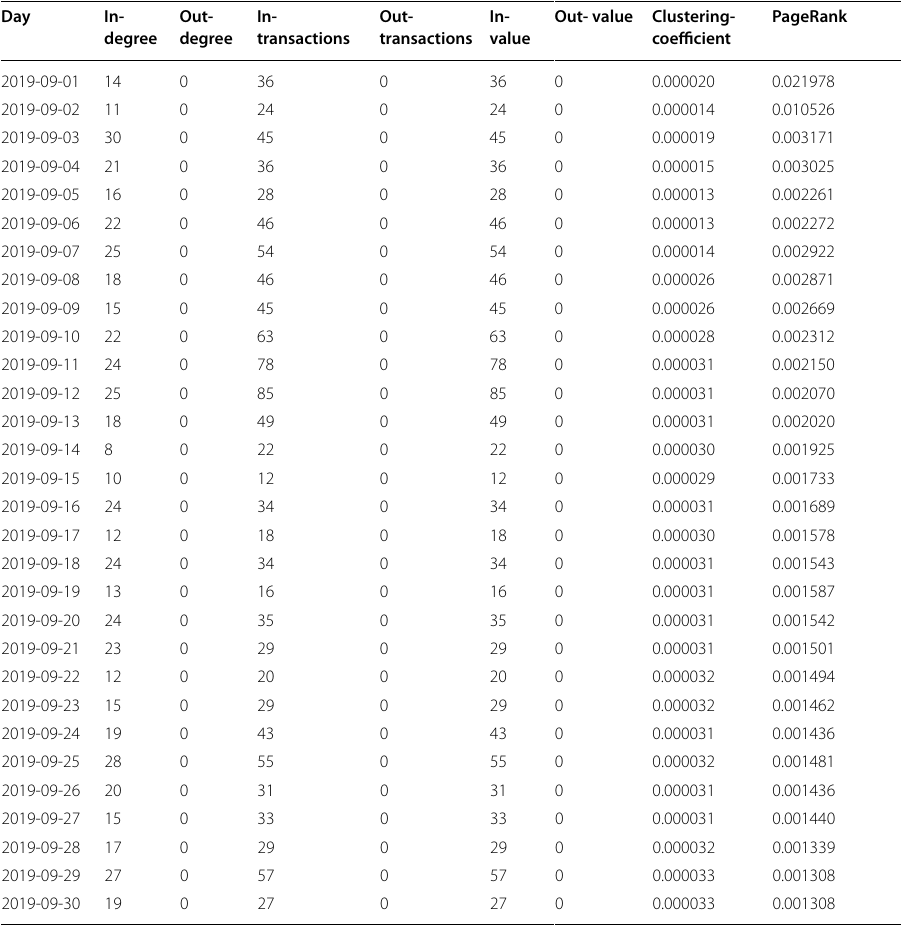
Table 2 An example of a user spectrum